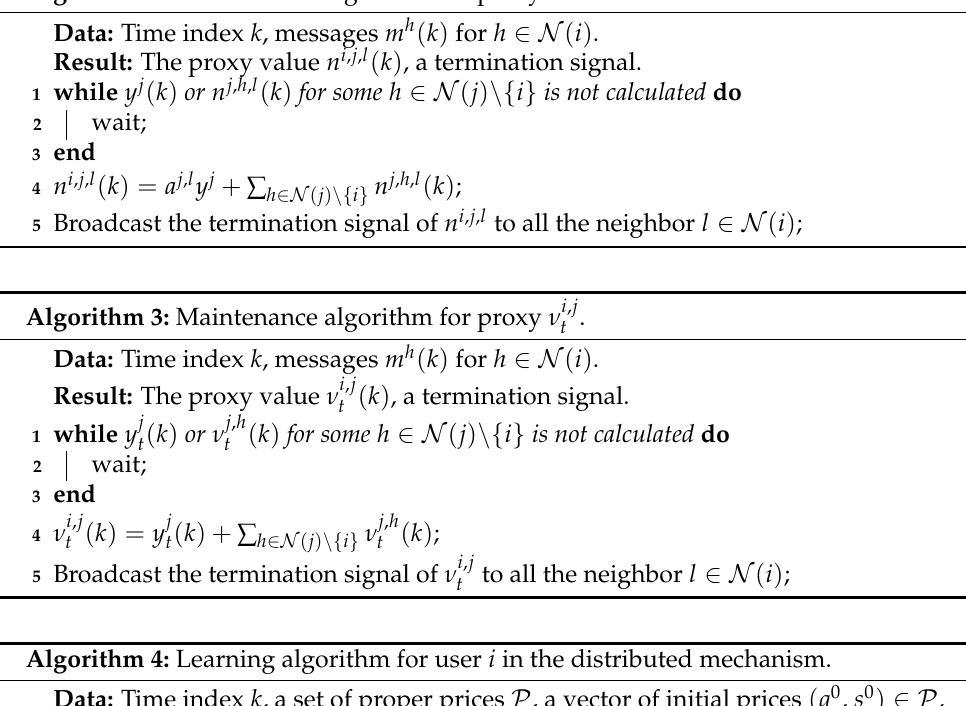
Algorithm 2: Maintenance algorithm for proxy n i , j , l .